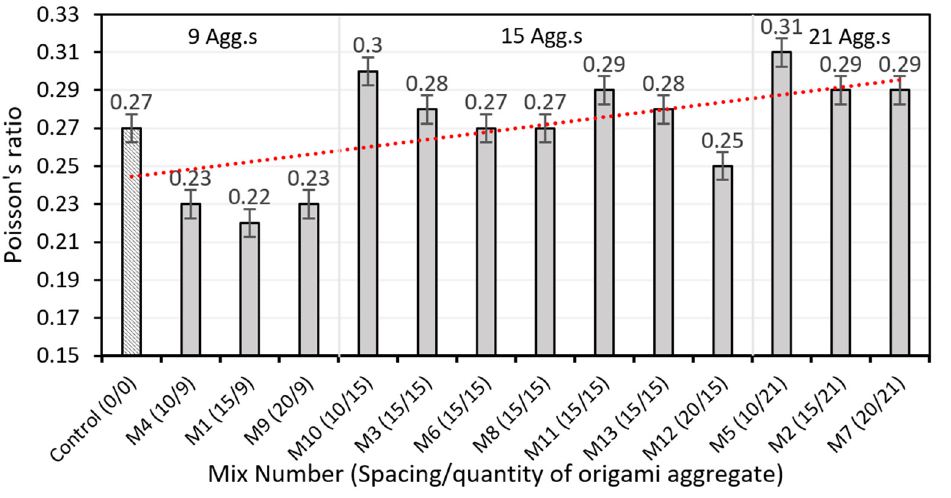
Figure 10. Poisson’s ratio of OBA ‐ RECC mixes at 28 days.